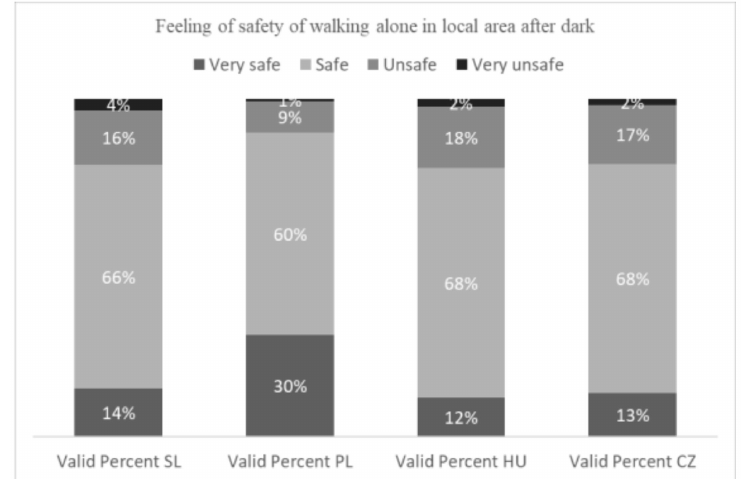
Figure 7. Responses regarding feeling safe walking in the dark